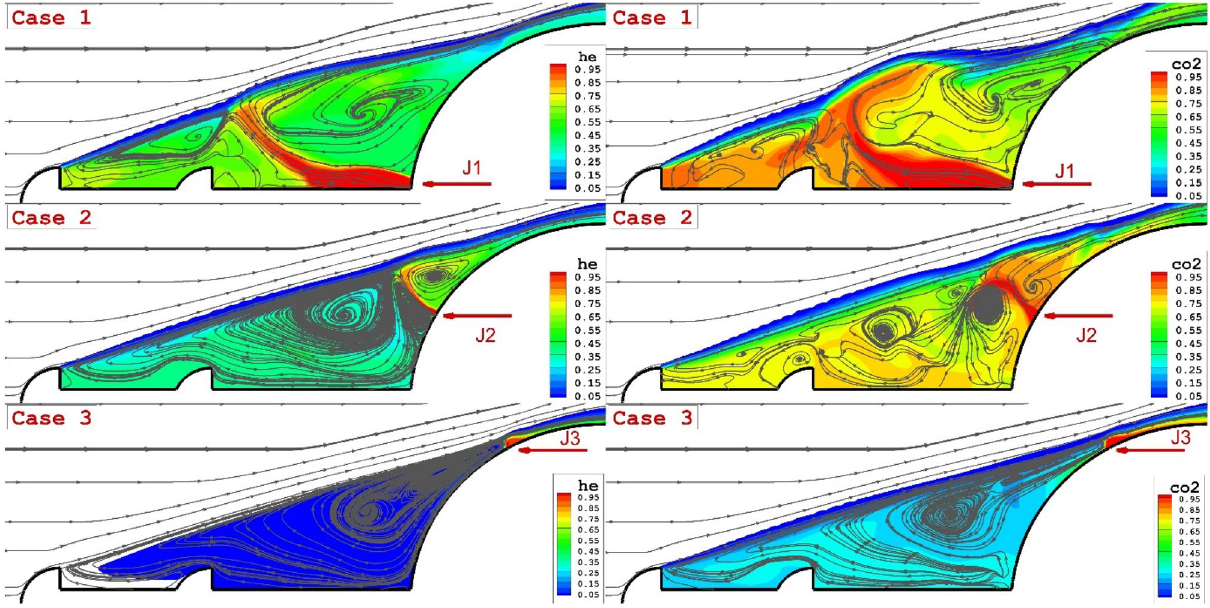
Figure 4. Comparison of helium (left side) and CO 2 (right side) opposing jet for different location on the main